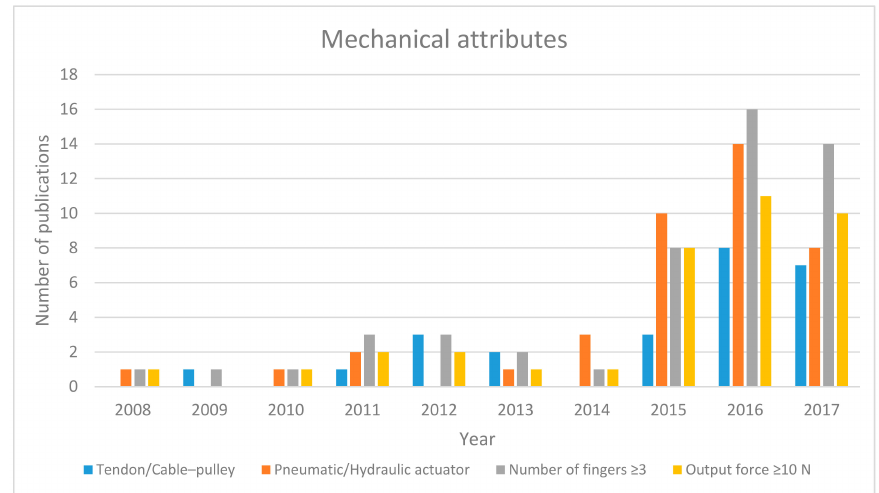
Figure 4. Mechanical development of soft robotic hand exoskeleton devices since 2008.